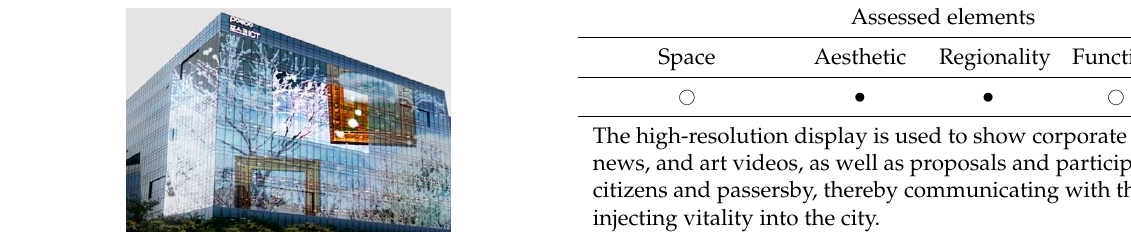
Table 7. Media facades: Smart Tower (Posco A&C 2011).